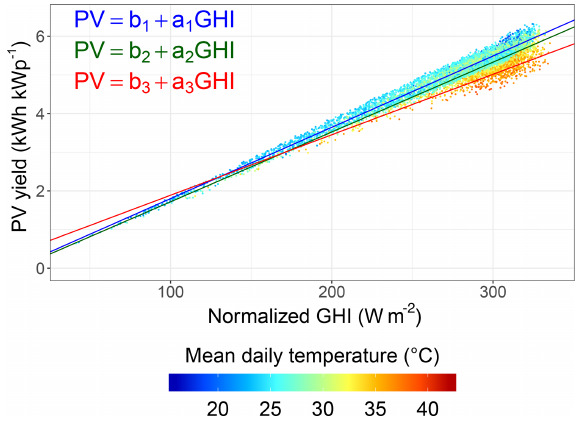
Figure 3. PV yield as a function of normalized global horizontal irradiance combining the calculations at all three measurement sites at three temperature levels: T ≤ 30 ◦ C (blue), 30 ◦ C < T ≤ 35 ◦ C (green), and T ≥ 35 ◦ C (red). The mean daily temperature is marked as shown in the color